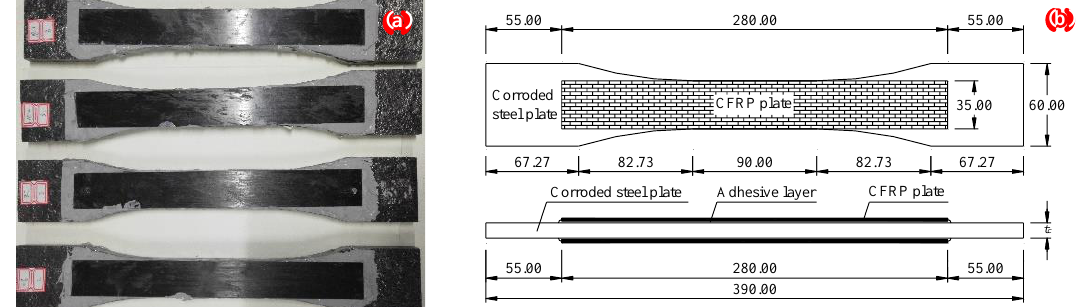
Figure 8. Prototype structures of the FEMs: ( a ) photograph of the specimens, ( b ) dimension and configuration of the corroded steel plate strengthened with CFRP plates.